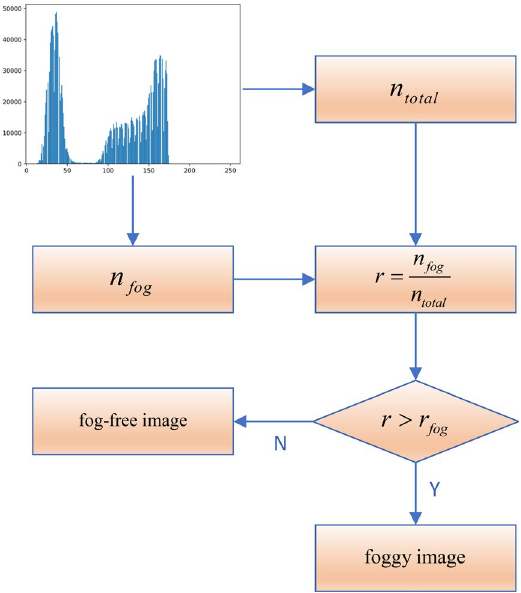
Figure 5. Flow chart of the fog detection